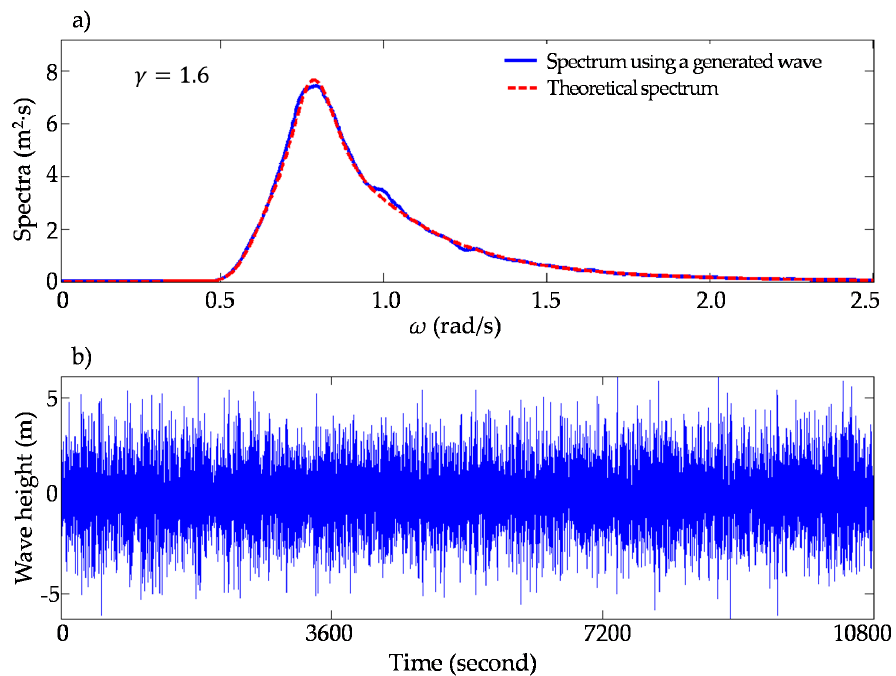
Figure 3. Comparison of the irregular wave height: ( a ) comparison between generated wave spectrum and theoretical spectrum, ( b ) irregular wave height (m) at the node located in the middle of the open boundary line .